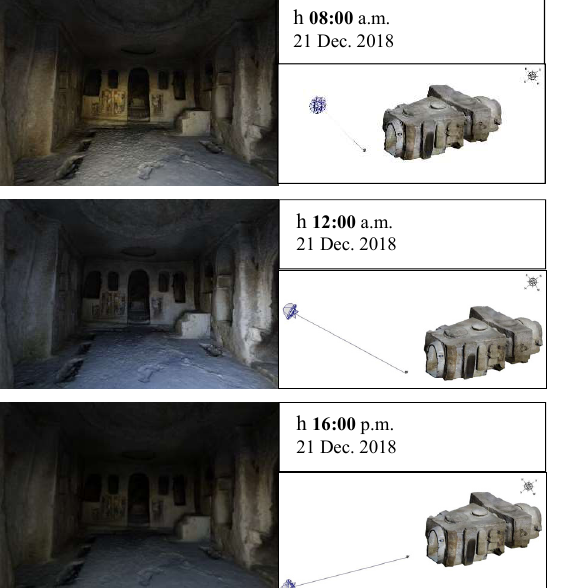
Figure 6: 3D Studio Max Sw. Photorealistic renderings of the nave during the winter solstice.